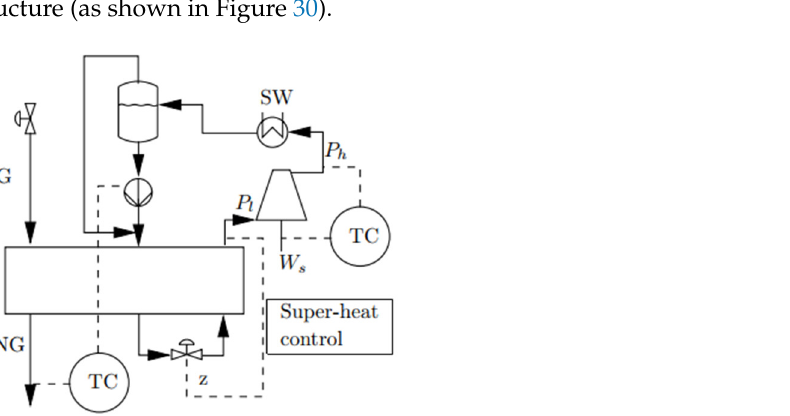
Figure 30. Simplified flowsheet of the PRICO process [110]. Reproduced with permission from IFAC meetings.